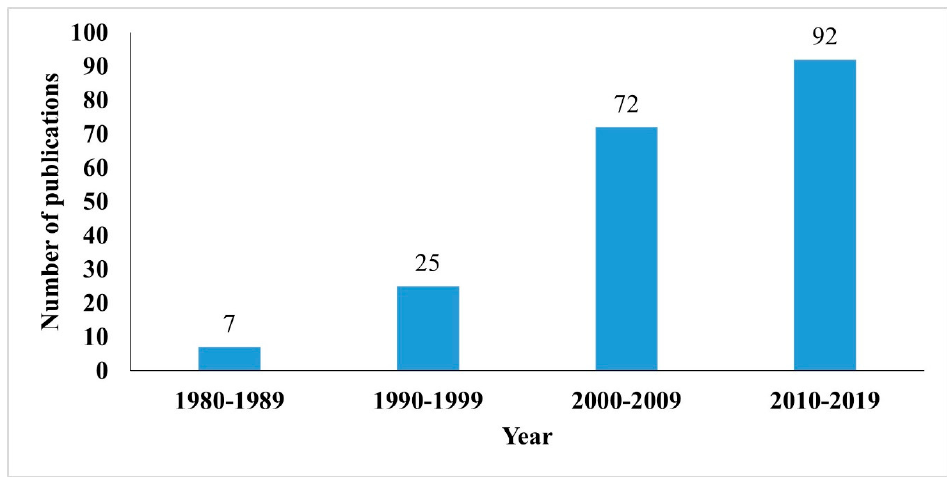
Figure 1. Scientific publications from 1980 to 2019 grouped into four